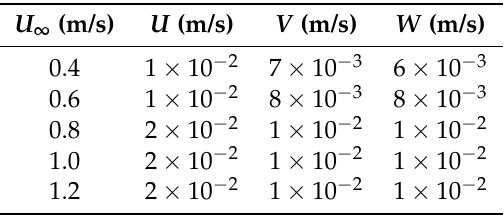
Table 2. Average expanded uncertainty estimates (with 95% confidence) for mean velocity measurements at each tow